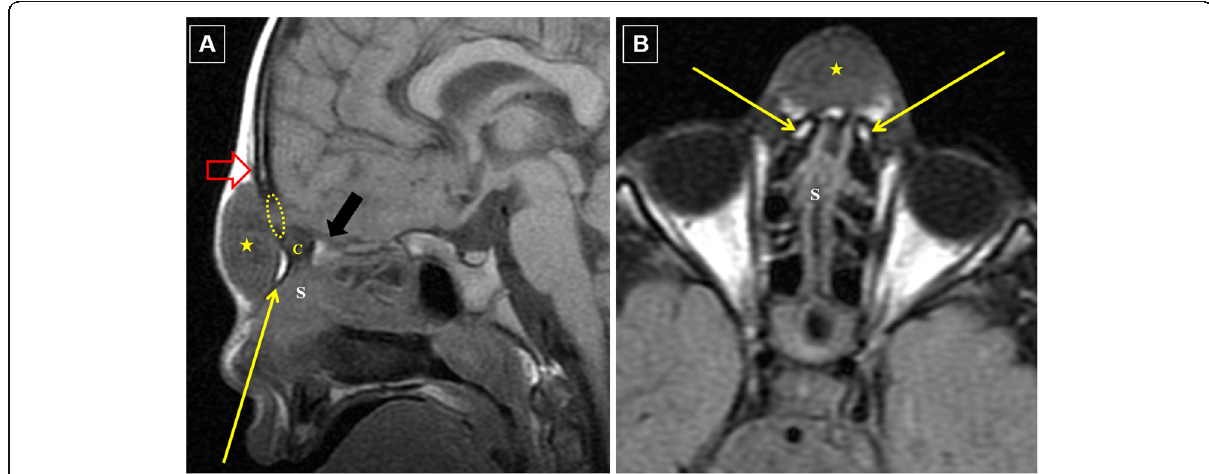
Fig. 3 Nasofrontal encephalocele. ( a ) (T1-weighted sagittal) and ( b ) (T1-weighted axial) images show herniation of intracranial content through the nasofrontal suture (fonticulus frontalis) shown by the dotted circle with the frontal bone (open arrow) seen superiorly and nasal bone (long arrow) inferiorly. These bones are identified by their fatty marrow. No herniation is seen through the foramen cecum (labeled C) located anterior to the crista galli (short arrow) which is also identified by its fatty marrow. Note the encephalocele sac (star) is noted anterior to the nasal bone (long arrow). No herniation through the foramen cecum and location anterior to the nasal bone differentiate it from the nasoethmoidal variant. Although all frontoethmoidal encephalocele (nasofrontal, nasoethmoidal, and nasoorbital types) usually herniate through the foramen cecum, in this case of nasofrontal encephalocele, no herniation is seen through the foramen